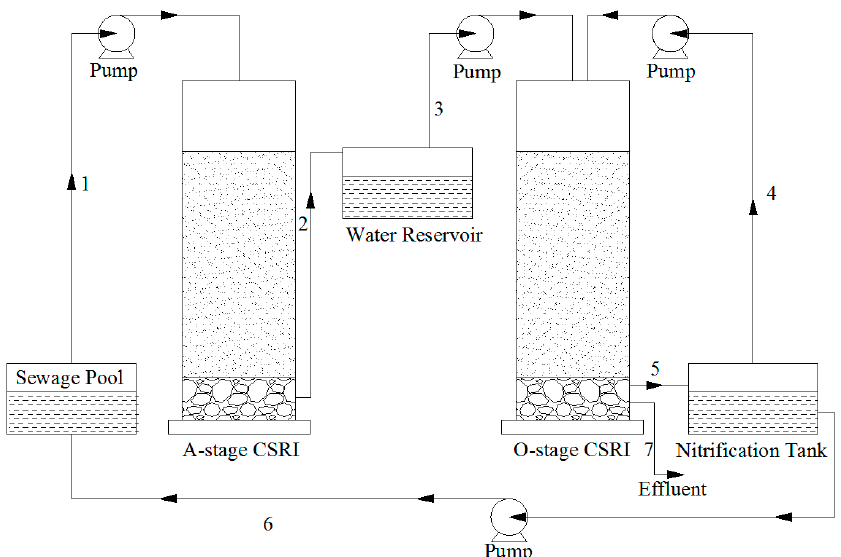
Figure 1. Schematic of the experimental constructed soil rapid infiltration (CSRI) model. For